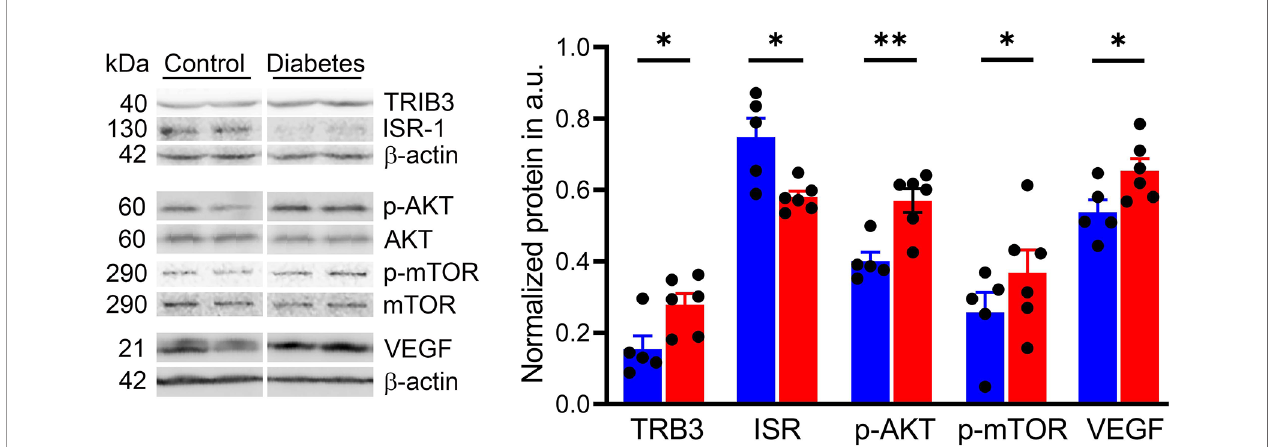
FIGURE 6 | Sustained hyperglycemia results in the alteration of cellular signaling in diabetic retinas. Representative images of the western blot membranes are shown on the left. The measured normalized values of the proteins in question are shown on the right. Reduced IRS expression was detected in diabetic retinas along with an increase in the p-AKT/p-mTOR pathway. In addition, we observed an increase in TRIB3 and VEGF expression, supporting our previous fi ndings in human and mouse diabetic retinas. *p < 0.05, **p < 0.01, (n=